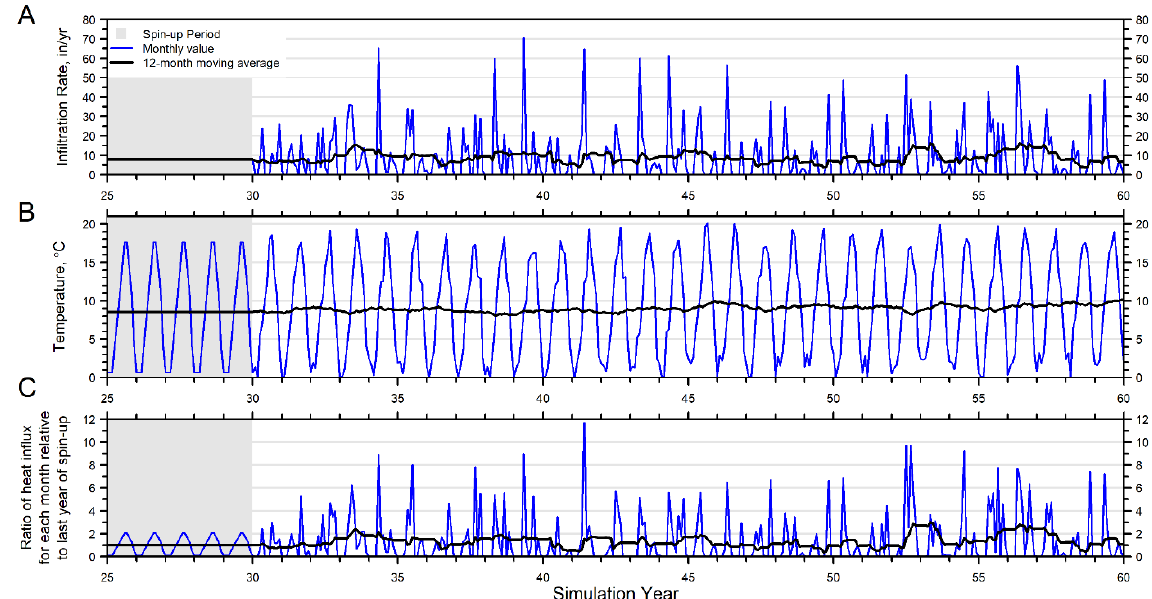
Figure 1. Forcing function applied to a synthetic model for a high emission (RCP8.5) warming scenario, corresponding to representative watershed in southern Wisconsin for warming period 2022–2051 (adapted with permission from Ref. [12]). ( A ) Monthly infiltration rates during the spin-up and warm-up periods. ( B ) Monthly infiltration temperatures during spin-up and warm-up periods. ( C ) A time series of the relative heat influx. Relative heat influx is calculated as the product of the monthly infiltration rates and temperatures for any given month in the warm-up period, divided by the average monthly heat influx during the spin-up period, resulting in a ratio that is referred to as the relative heat influx.